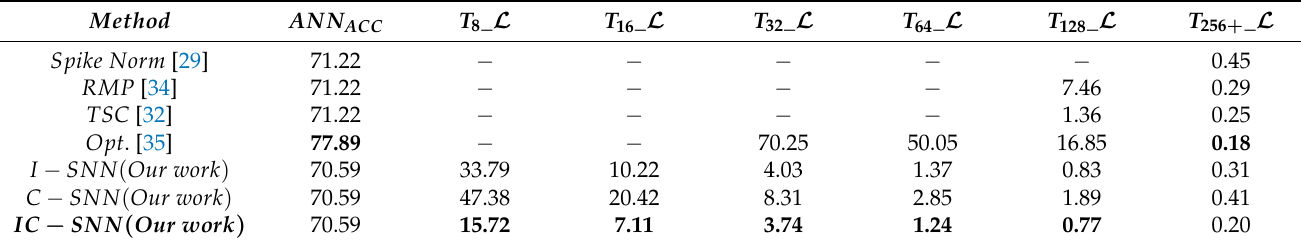
Table 3. Results of the test on the CIFAR100 dataset using VGG16.